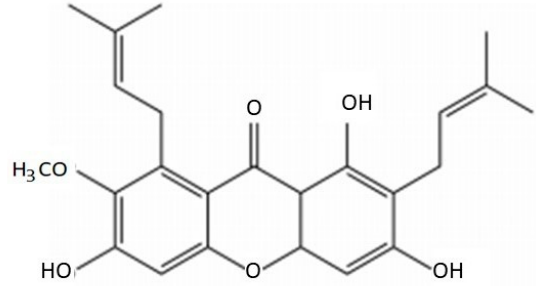
Figure 1. Composition of α